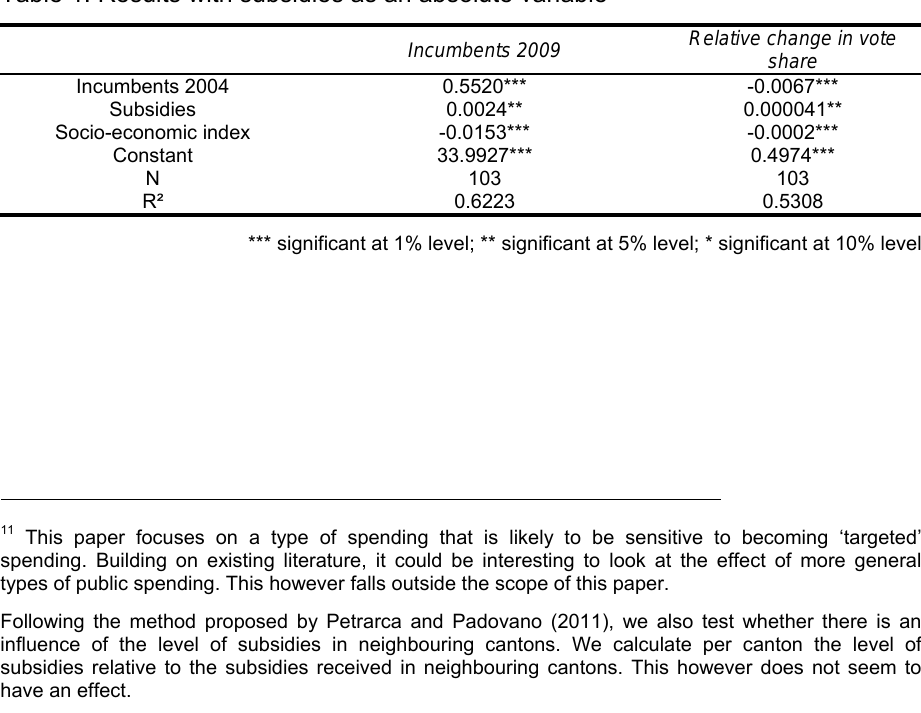
Table 1: Results with subsidies as an absolute variable